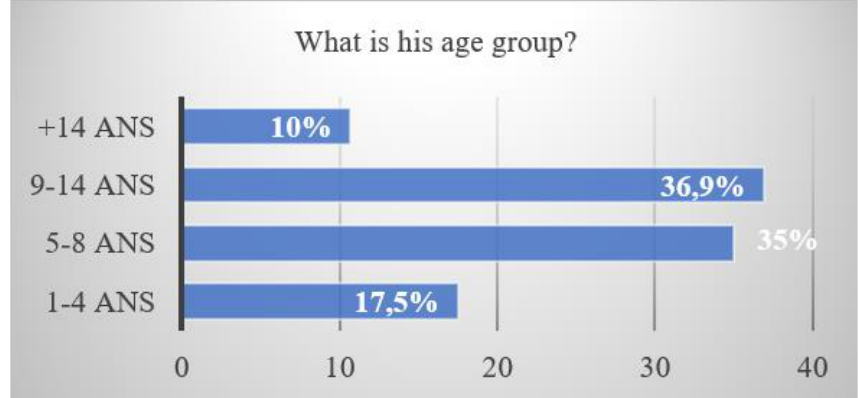
Figure 1. Distribution of Autistic Children According to Their Age Group